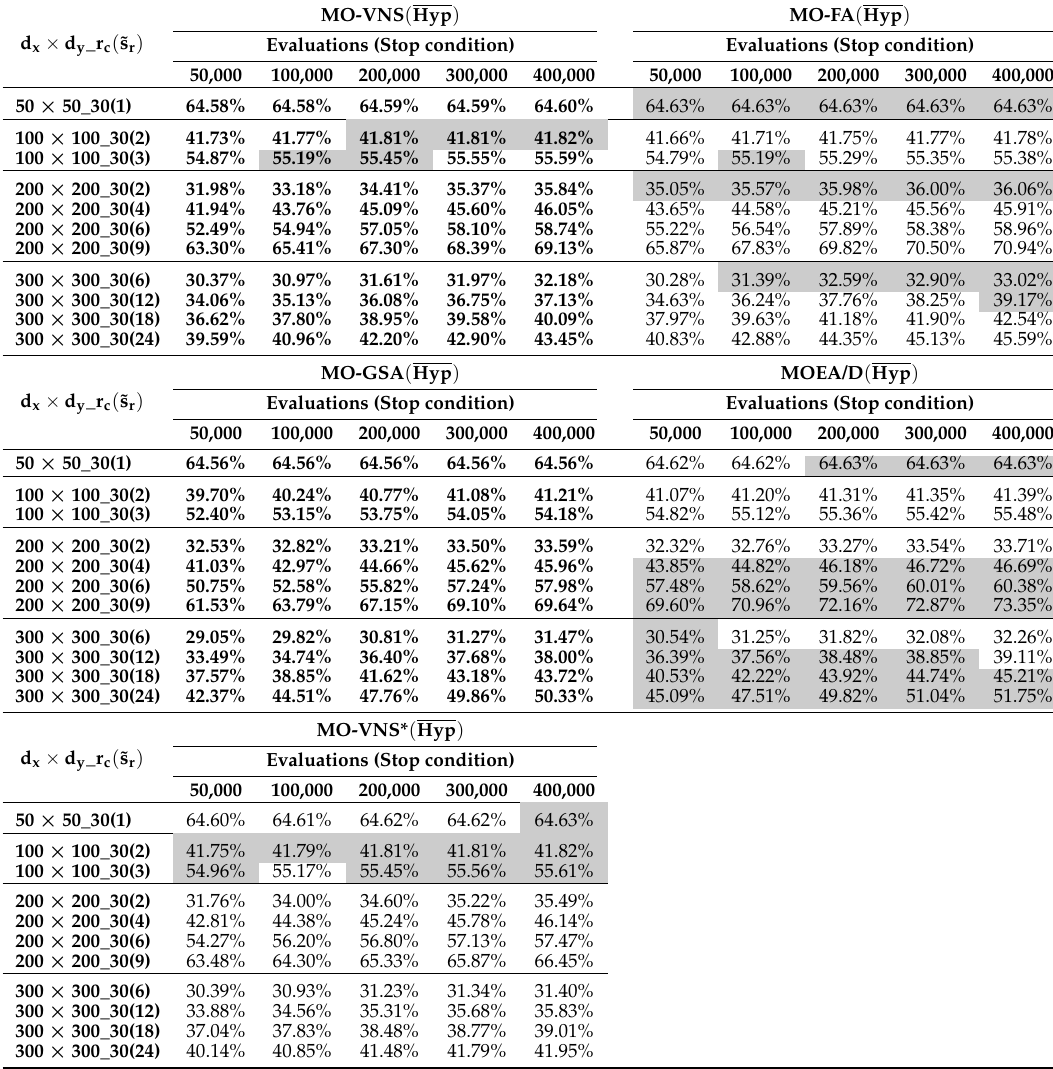
Table 6. Median hypervolume obtained solving the three-objective RNPP.